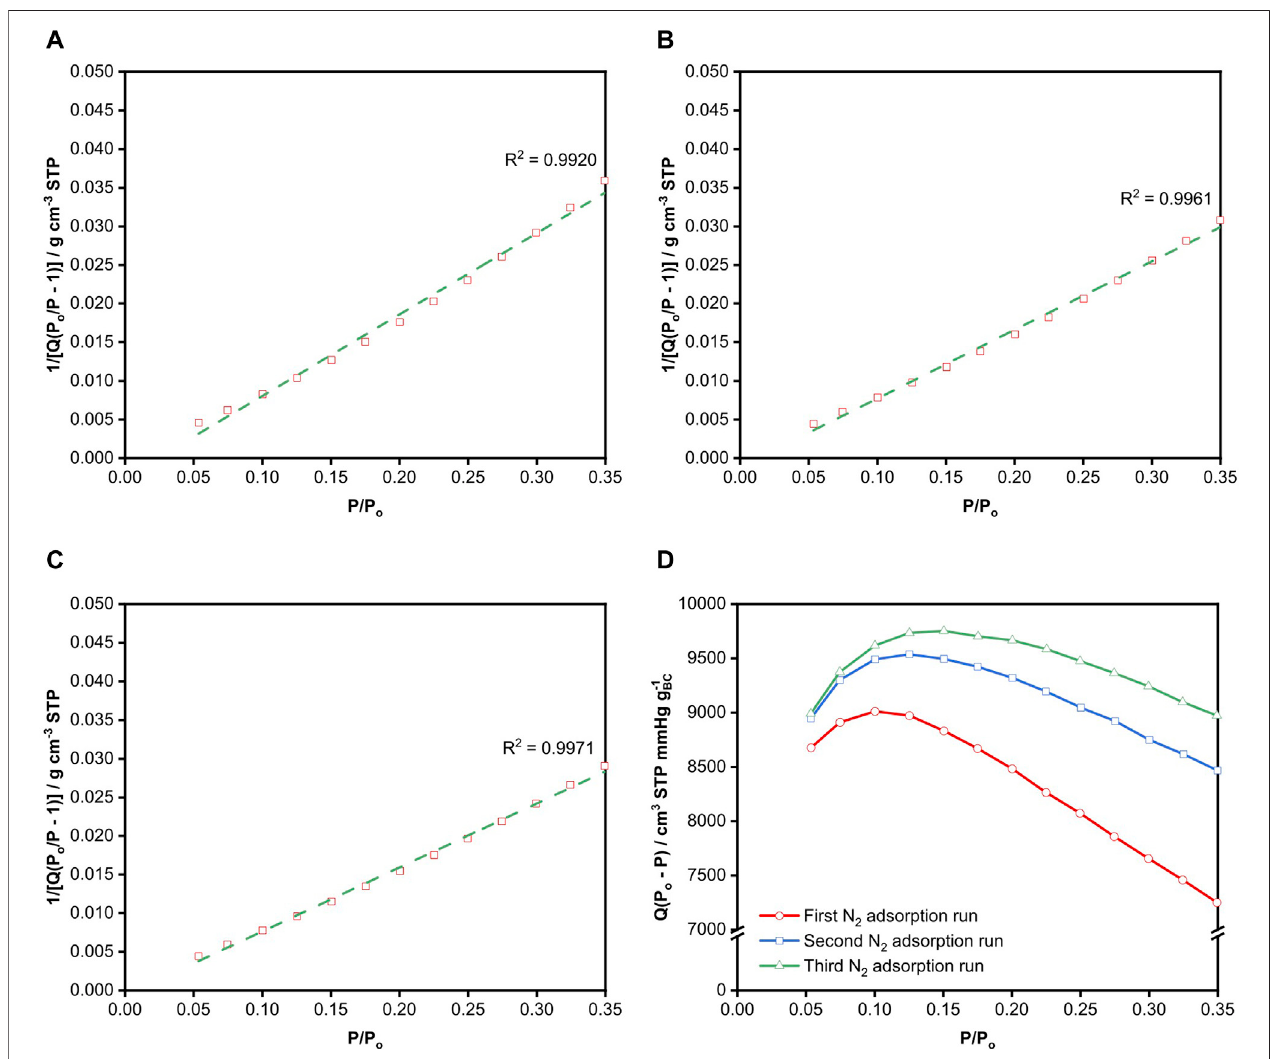
FIGURE2| BETplotsoffreeze-dried BCobtainedfromthe (A) fi rst, (B) secondand (C) thirdN 2 adsorptionruns. Thedottedgreenlinescorrespondtothelinear fi t of the data within the BET range of 0.05 ≤ P / P o ≤ 0.35. (D) Q ( P o − P ) vs P / P o plot of freeze-dried BC based on volumetric BET measurements, showing that only the P / P o range of below 0.10 satisfy the conditions outlined.